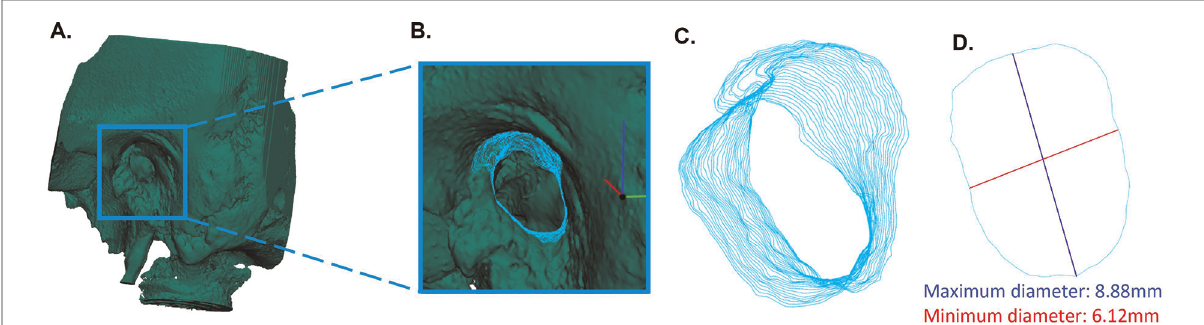
FIGURE 2 Measurement of the minimum and maximum diameter of the osseous external auditory canal (OEAC). ( A ) Segmentation and conversion of the preoperative temporal bone images into a three-dimensional (3D) model. ( B ) Detection of the elliptical shape of each 0.3 slice of the OEAC in the preoperative 3D model. ( C ) Crossections of the OEAC perpendicular to the viewing direction of the otorhinolaryngologist. ( D ) The maximum diameter (blue line) and minimum diameter (red line) of one slice of the OEAC.